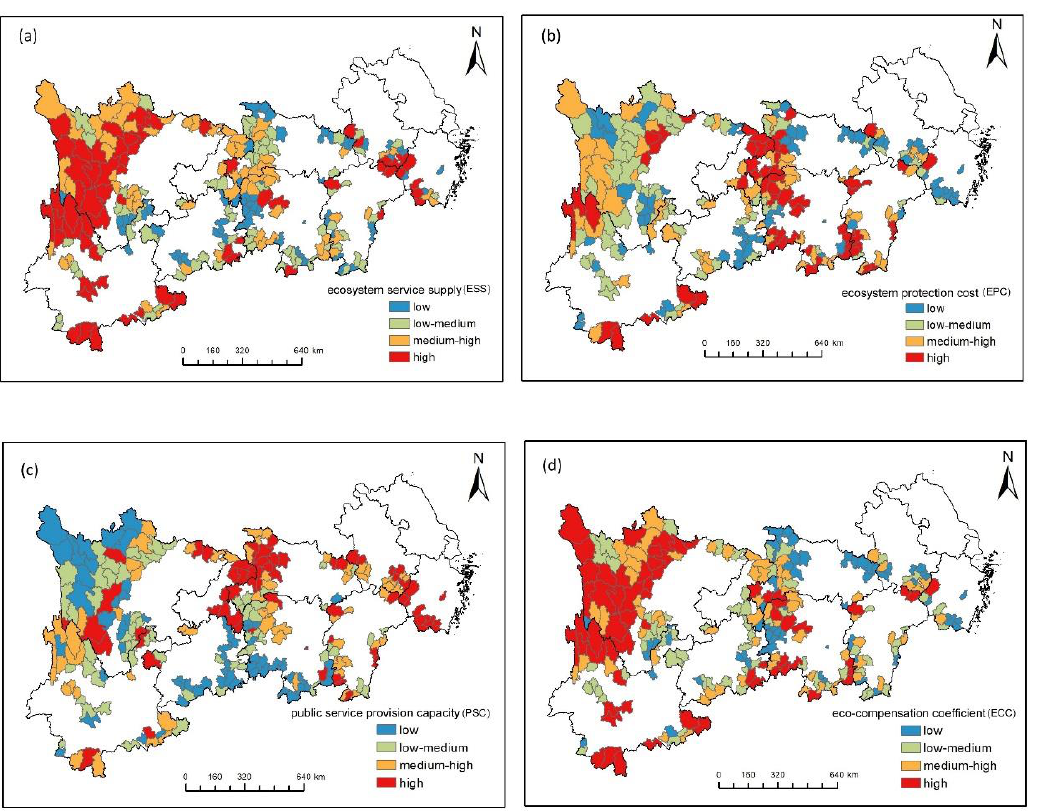
Figure 5. Mapping of ecosystem service supply ( a ), ecosystem protection cost ( b ), public service provision capacity ( c ), and eco-compensation coefficient ( d ) for national key ecological function counties in the Yangtze River Economic Belt.